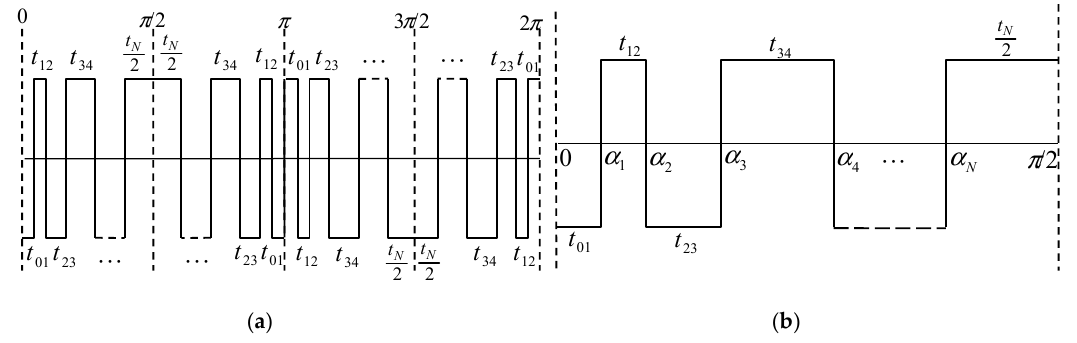
Figure 2. ( a ) Bipolar dual-frequency programmed harmonic modulation (PHM) waveform and ( b ) its quarter cycle.